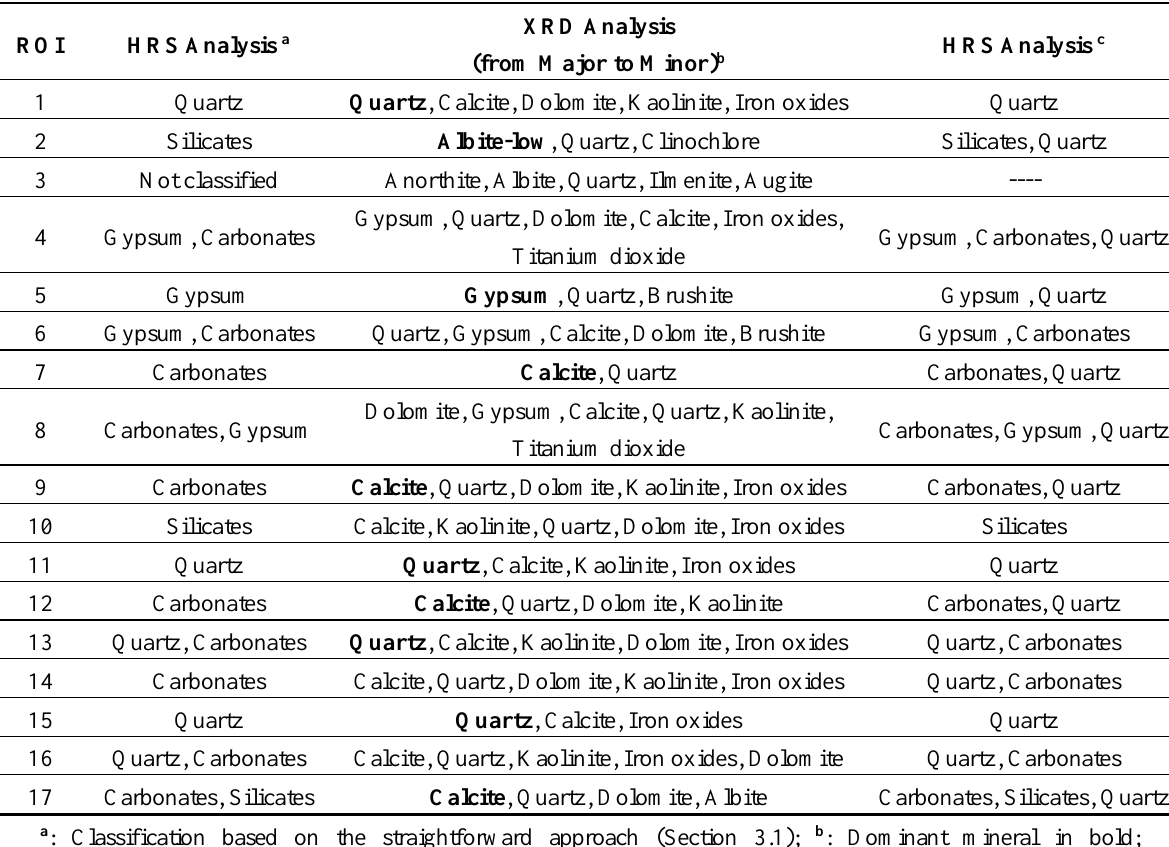
Table 3. Mineral classification—HRS analysis vs. XRD